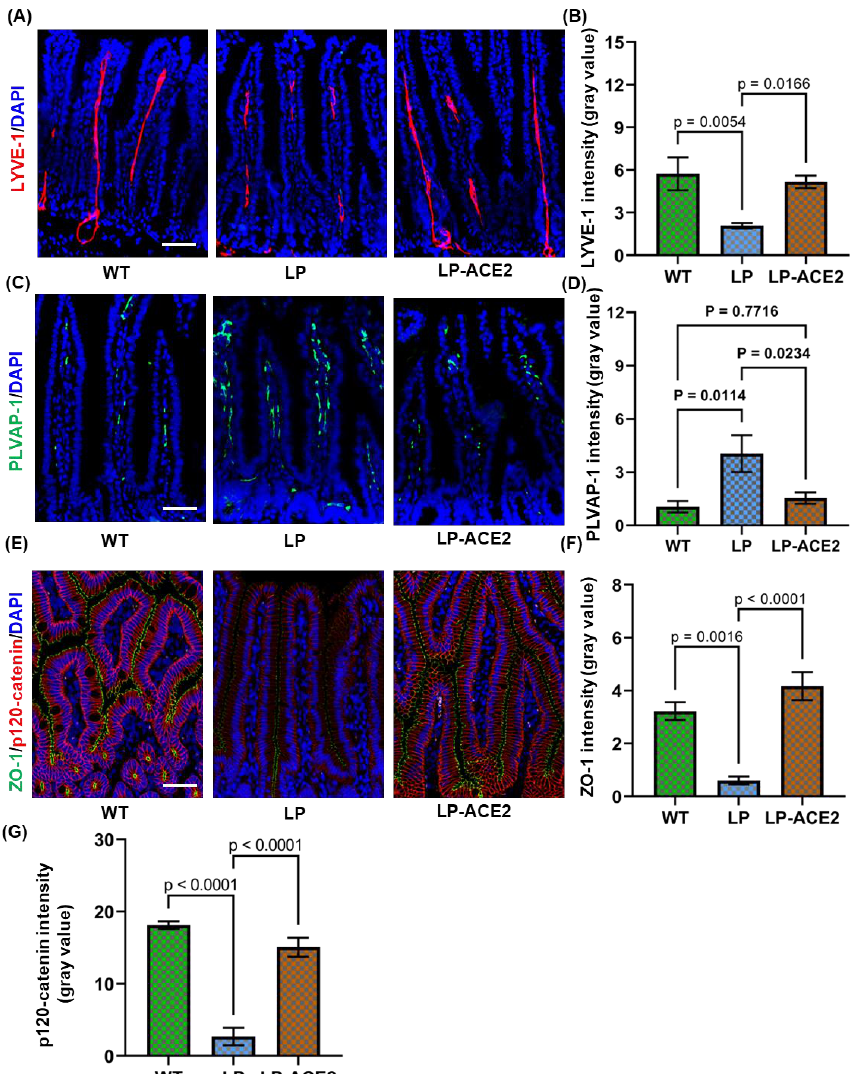
Figure 1. Oral administration of LP-ACE2 corrects hyperglycemia-induced lacteal disruption and improves gut barriers in Akita mice. Representative staining for LYVE-1 (red) in the lymphatic capillaries (lacteals) and quantification ( A , B ). The endothelial expression of PLVAP-1 (green) and its quantification ( C , D ). The intestinal barrier defects are detected by ZO-1 (green) and p-120 catenin (red) in all three cohorts ( E ). The quantification of ZO-1 and p120-catenin ( F , G ). The quantification of immunofluorescence staining is represented as mean intensity of gray values ± S.E.M of gray values. Nuclei were stained with DAPI (Blue). Data are analyzed by one-way ANOVA adjusted to account for multiple comparisons using Tukey’s test. Scale bar = 50 μm ( n = 6).